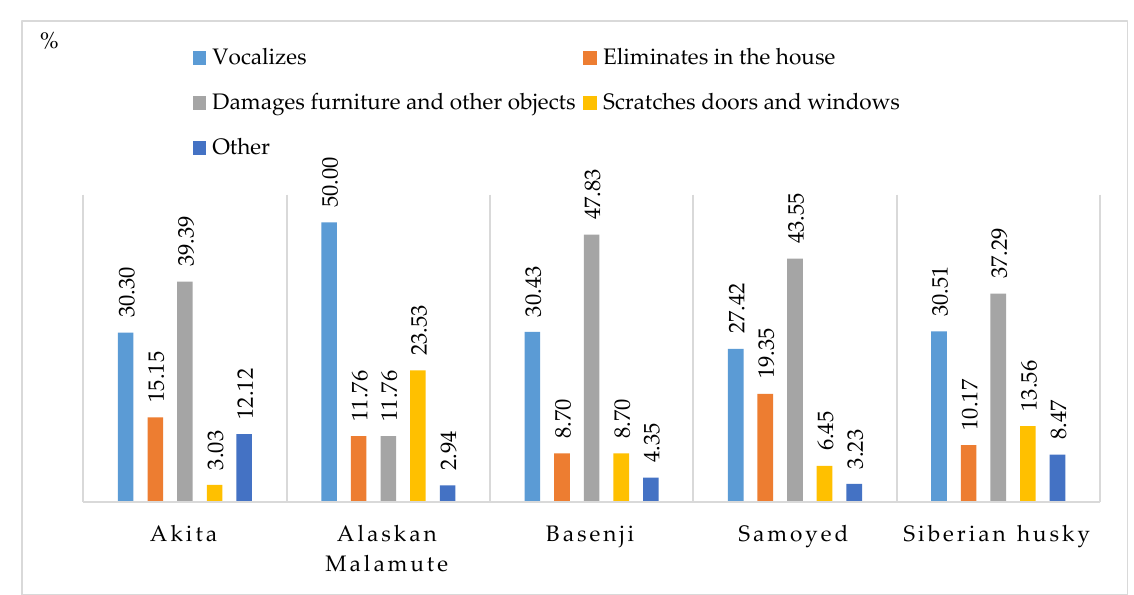
Figure 6. Undesirable behaviors when dogs are left alone at home (indicative of separation anxiety) (%).